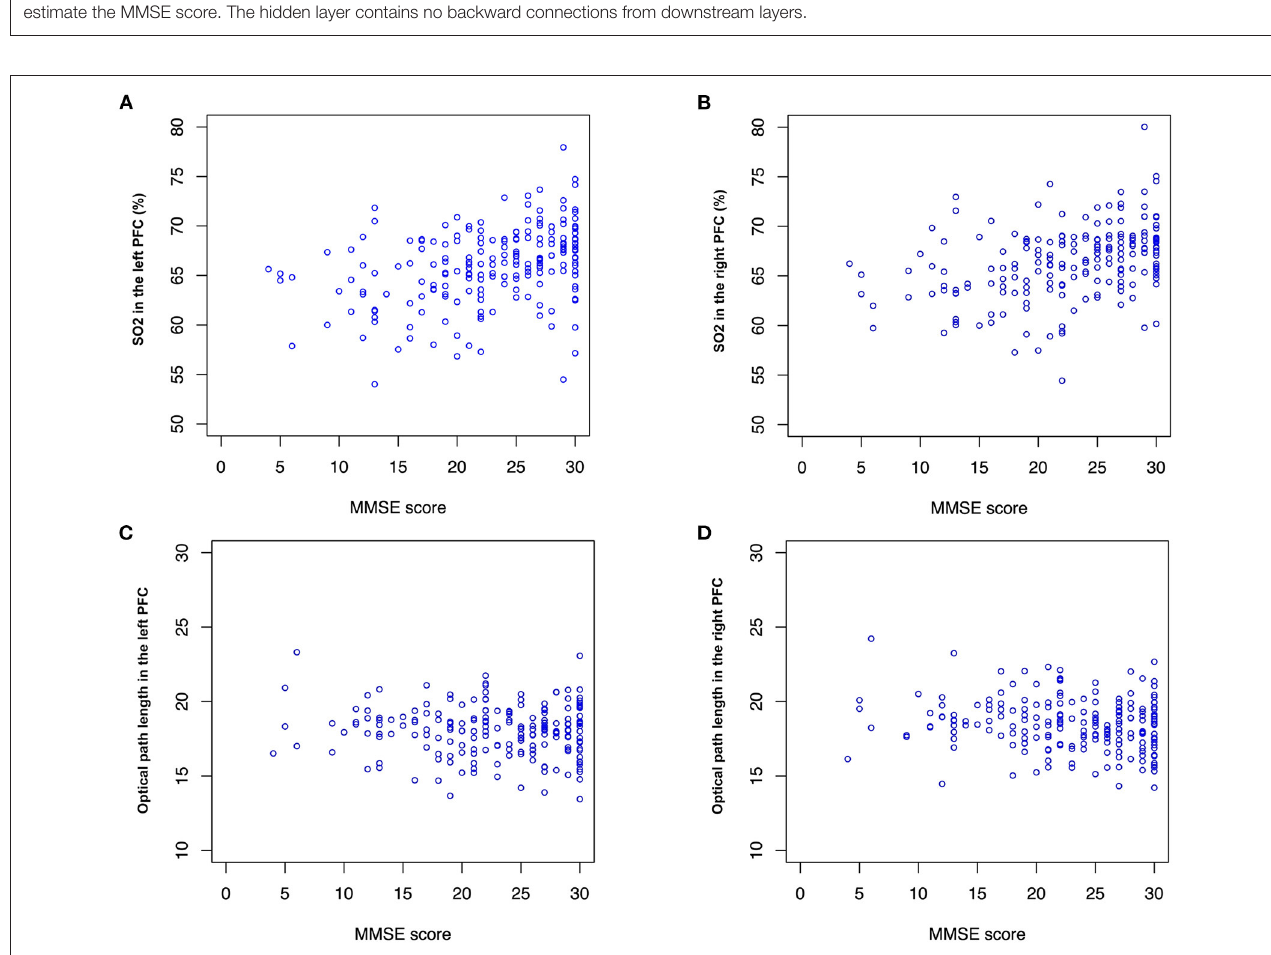
FIGURE 4 | SO 2 and optical path length (OP). MMSE score is correlated with (A) SO2 in the left and right PFC ( r = 0.30, p < 0.01) and (B) right PFC ( r = 0.30, p < 0.01). No significant correlation between MMSE score and OP is found, however, mean values of OPs in (C) the left PFC (mean: 17.9 and 18.0, p < 0.1) and (D) the right PFC (mean: 18.2 and 18.6, p < 0.1) are different between the normal and impaired